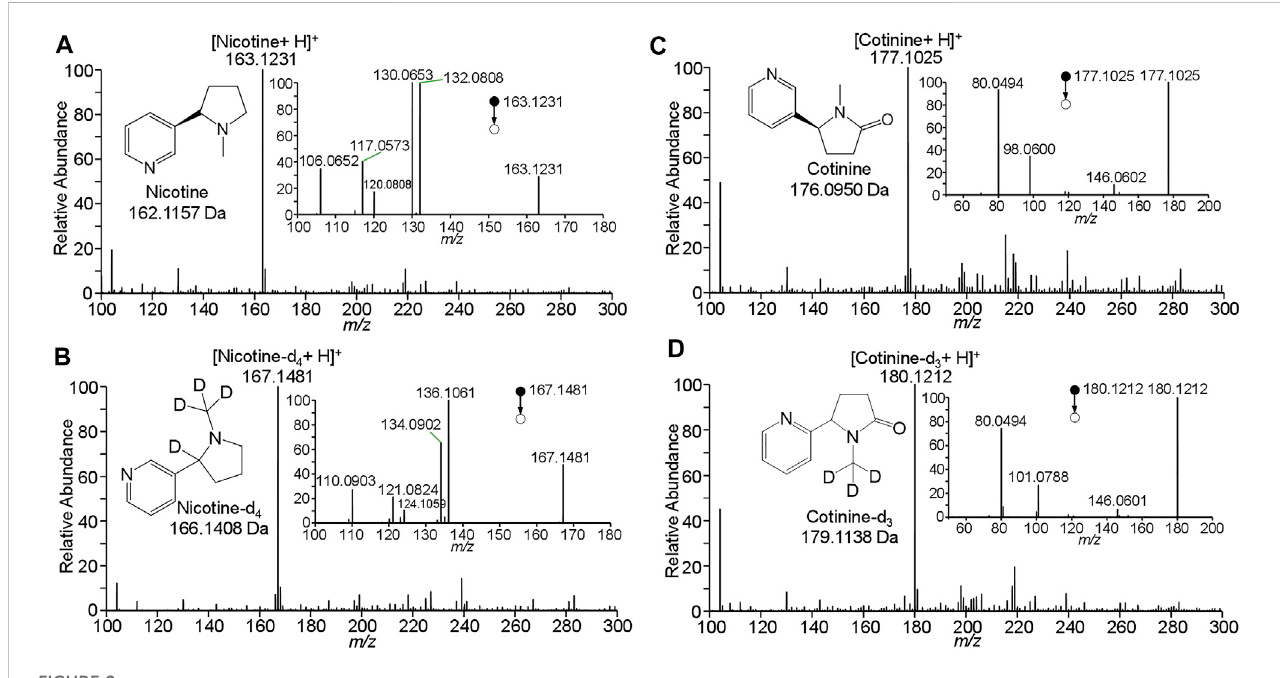
FIGURE 2 WTS-MS detection of nicotine and cotinine: (A) nicotine, (B) nicotine-d4, (C) cotinine, (D) cotinine-d3.